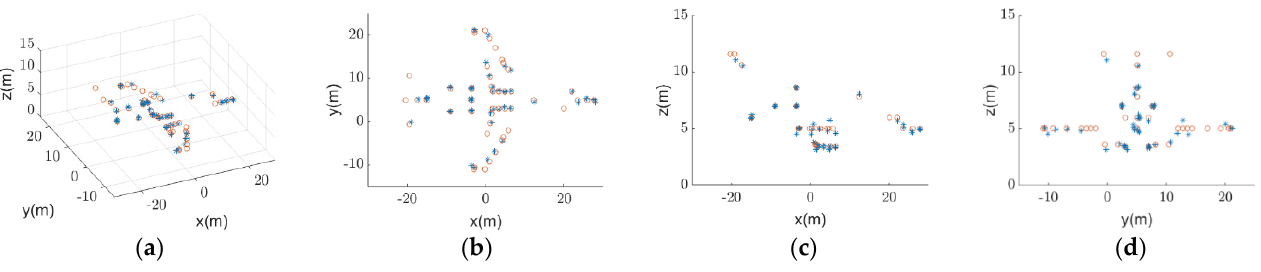
Figure 11. 3D imaging results obtained by the method in [25] with the scatterer at position (9.995, 9.995, 9.995) km taken as the reference scatterer in ( a ) 3D; ( b ) projection on x-y plane; ( c ) projection on x-z plane; ( d ) projection on y-z plane. Table 3. Comparison of RMSEs and runtimes of our method and the method in [25].